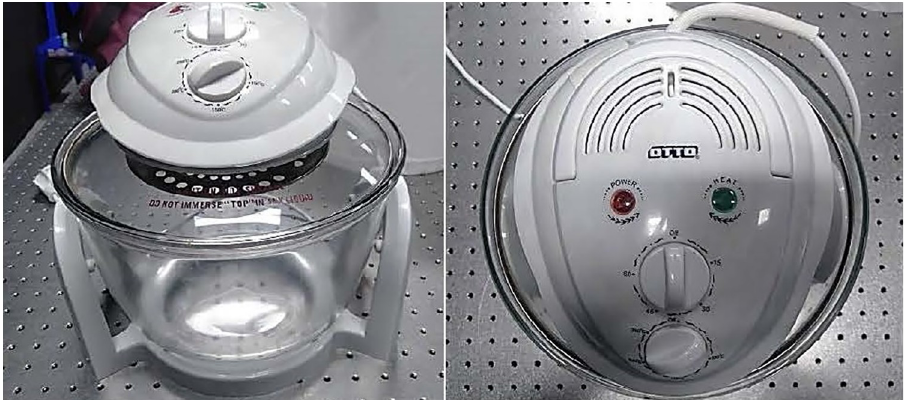
Fig 4. Heat bower